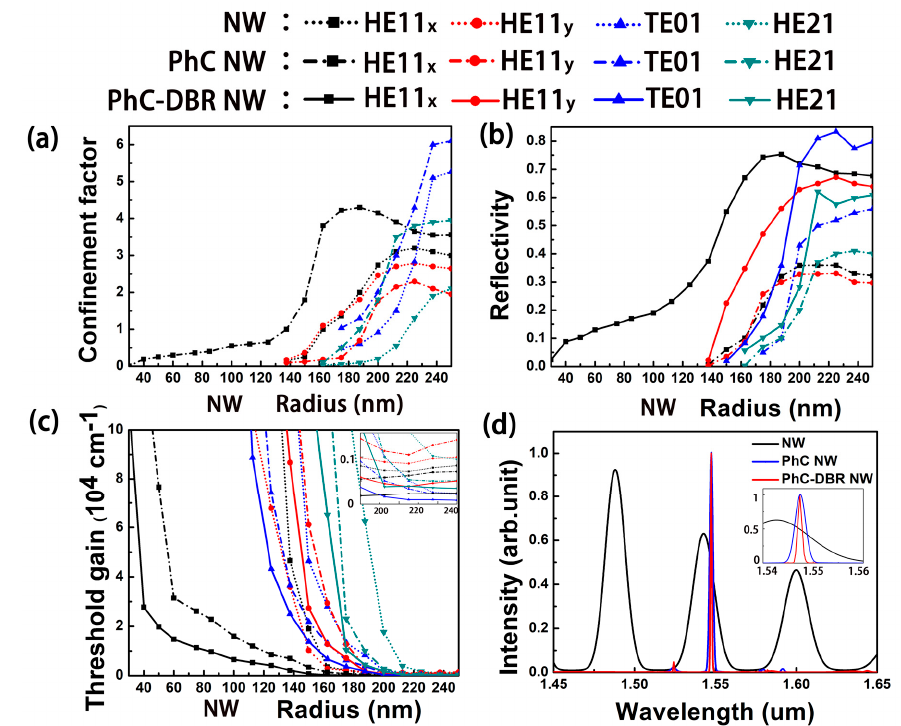
Figure 6. ( a – c ) Radius-dependent confinement factor, reflectivity, and threshold gain of NW lasers with di ff erent structures. ( d ) Longitudinal modes of HE11 x mode in three structures with a radius of 170 nm.